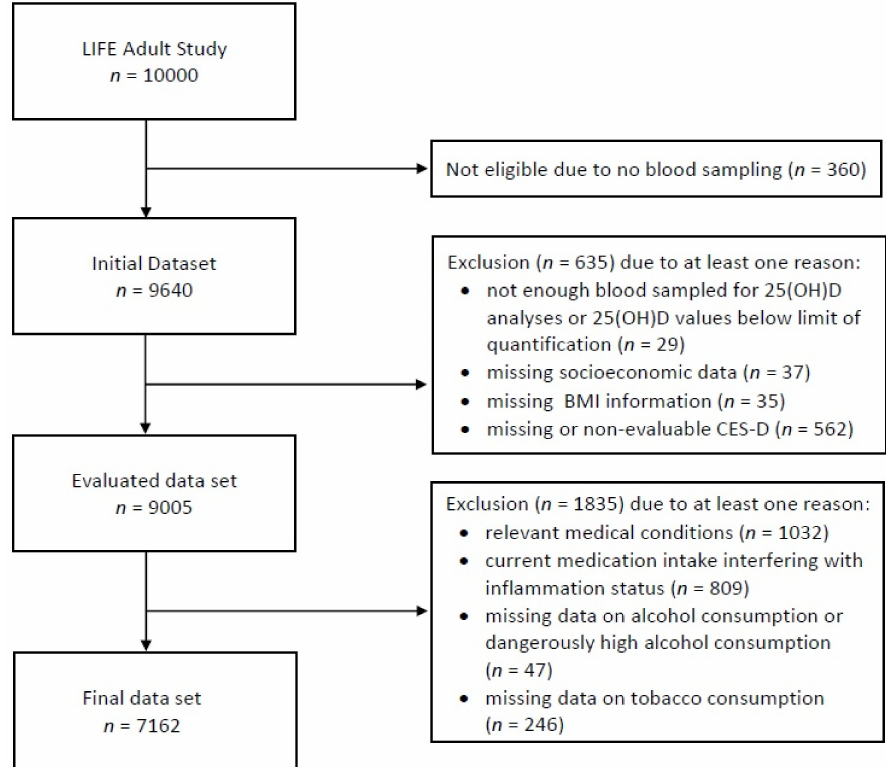
Figure 1. Flow diagram of data selection process. BMI: body mass index, CES-D: German version of the Centre for Epidemiological Studies Depression Scale [30], 25(OH)D: 25-Hydroxyvitamin